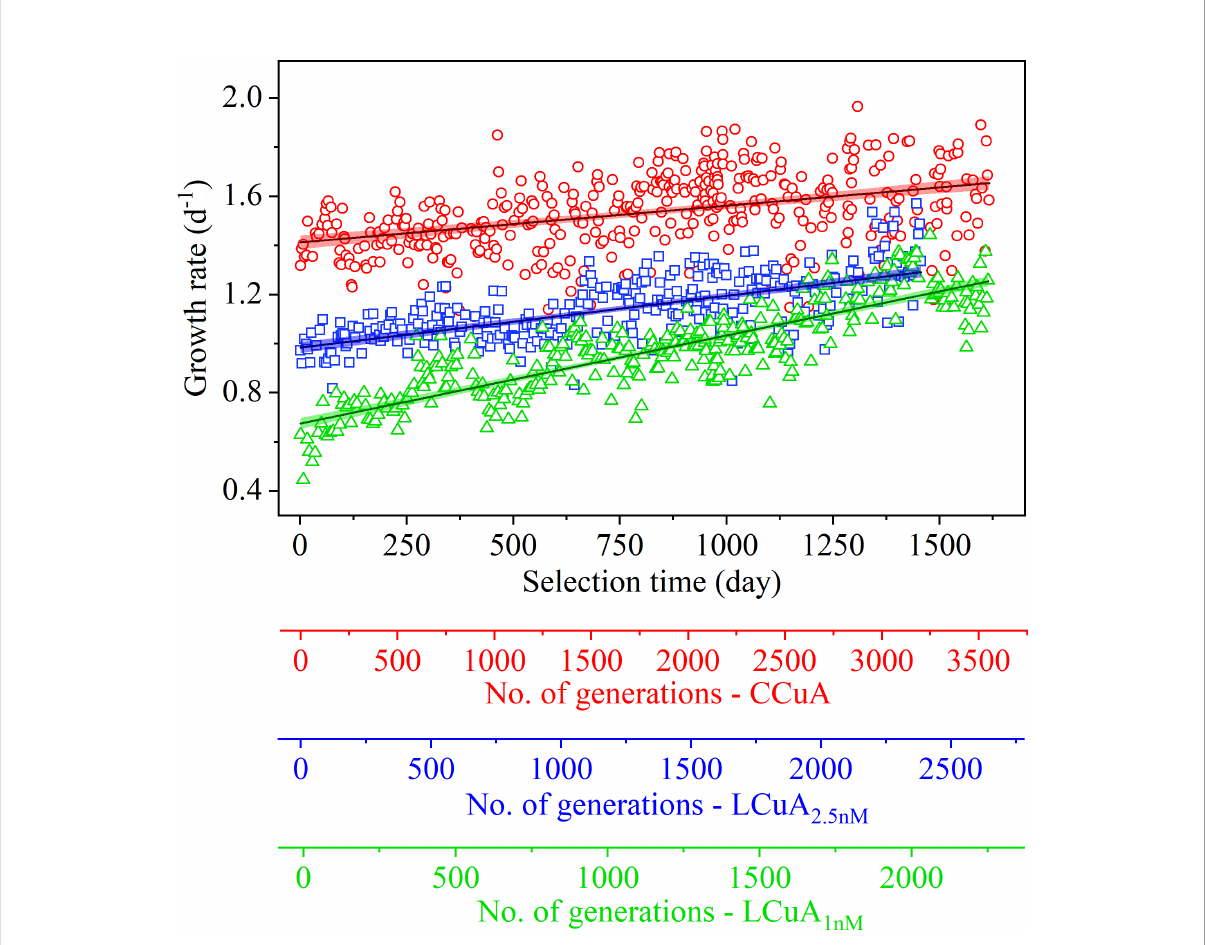
FIGURE 2 Speci fi c growth rate (d -1 ) of T. oceanica as a function of selection time in Cu-suf fi cient ( ○ ) and Cu-de fi cient medium containing 2.5 nM ( ◻ ) or 1 nM ( △ ) Cu. The number of cell generations corresponding to the selection time is reported for the control (CCuA) and low Cu-adapted (LCuA 2.5nM , LCuA 1nM ) populations. Each data point represents the speci fi c growth rate of one batch culture. Solid lines are the least squares linear regressions of growth rate as a function of selection time for each population. Color bands surrounding the regression lines represent the 95% con fi dence